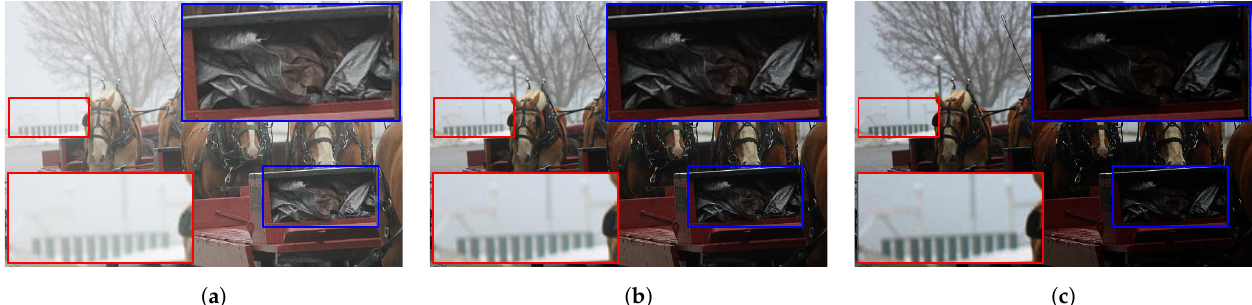
Figure 4. Illustration of under-exposure’s effects on the hazy image. ( a ) Hazy image and its corresponding under-exposed results with ( b ) γ = 2 and ( c ) γ =